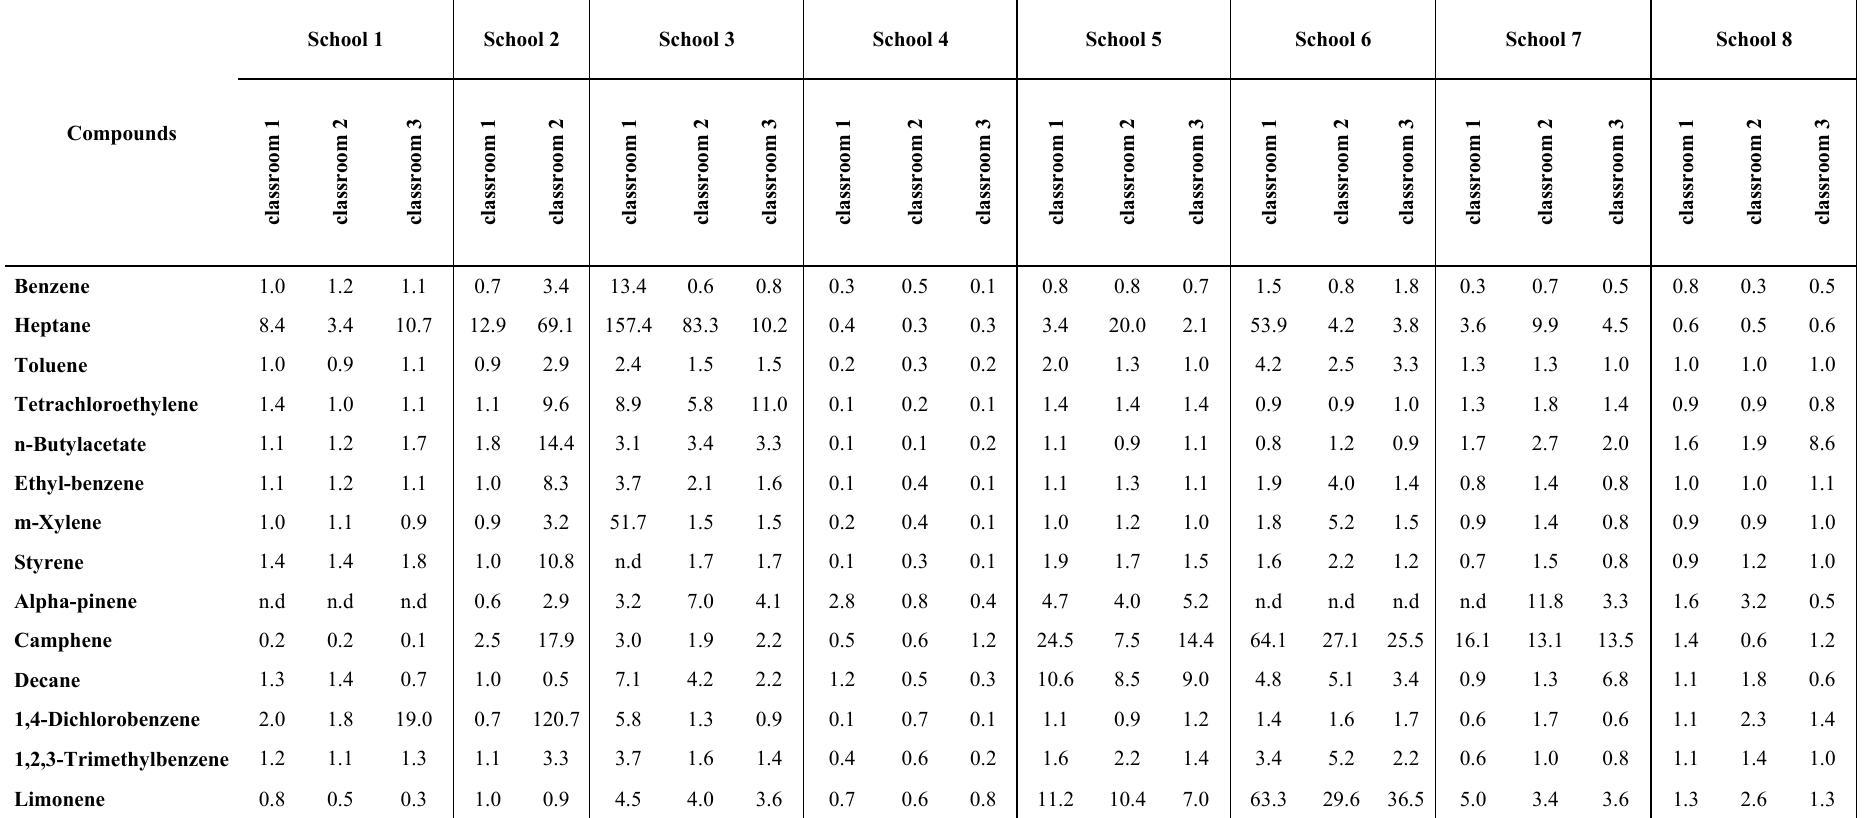
Table 5. I/O ratios for each monitored